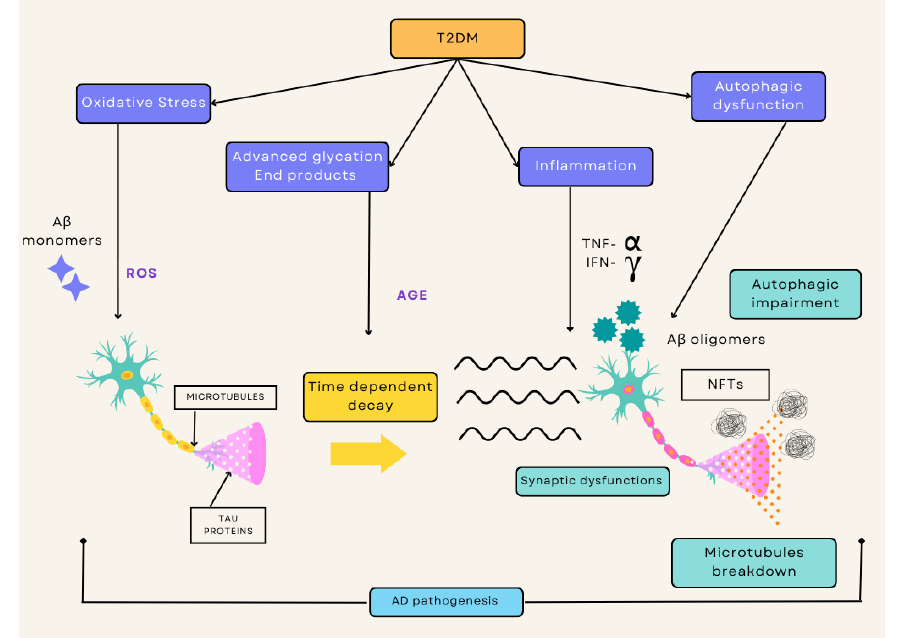
Figure 1. Overview of the diverse mechanisms by which T2DM and AD crossover with one